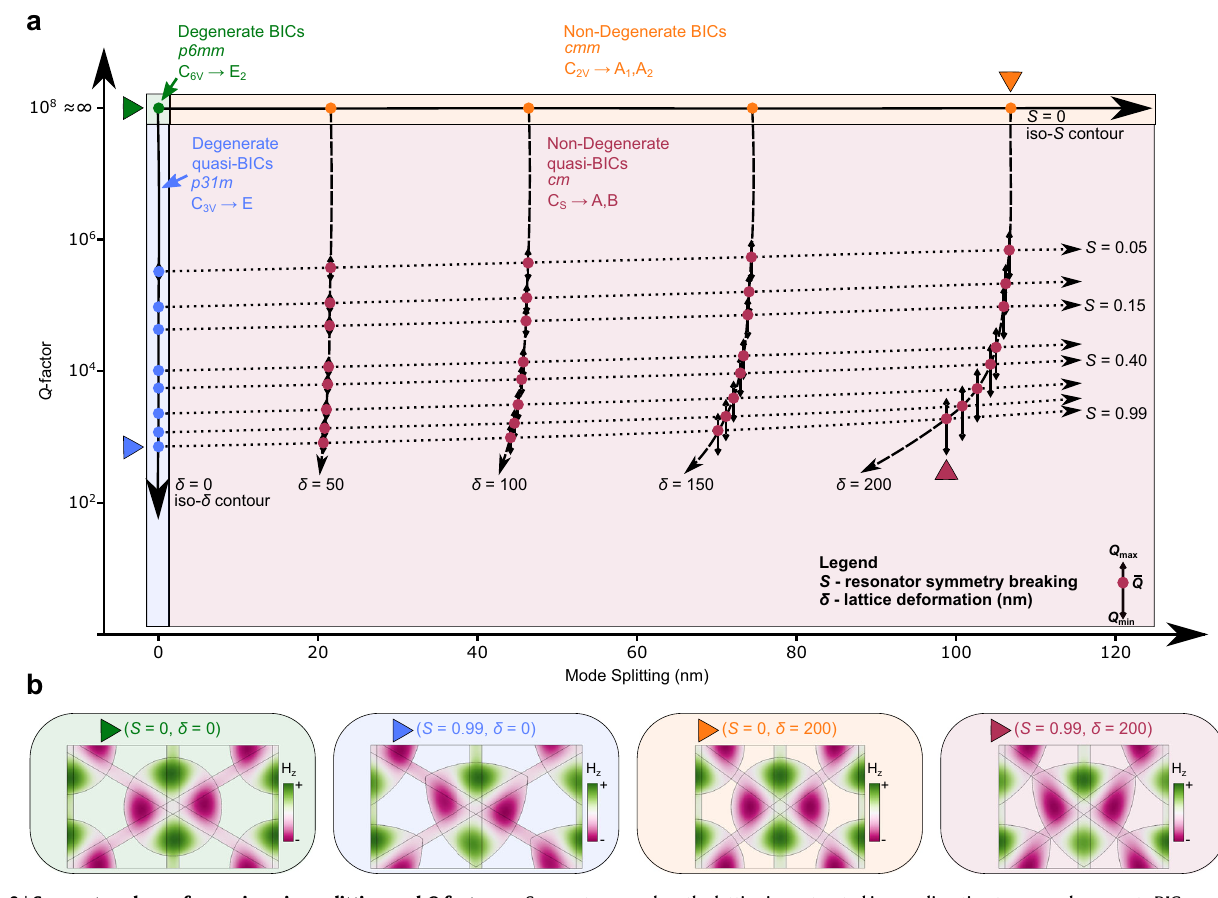
whenthelatticeiscontractedinonedirectiontwonon-degenerateBICsareformed sinceonly C 3 symmetryisbroken.Withthesetwosymmetry-breakingparametersit is possible to design a lattice with cm C s symmetry capable of having non- degeneratequasi-BICswitharbitrarysplitting and Q -factors. b Fieldpro fi lesforthe four symmetry